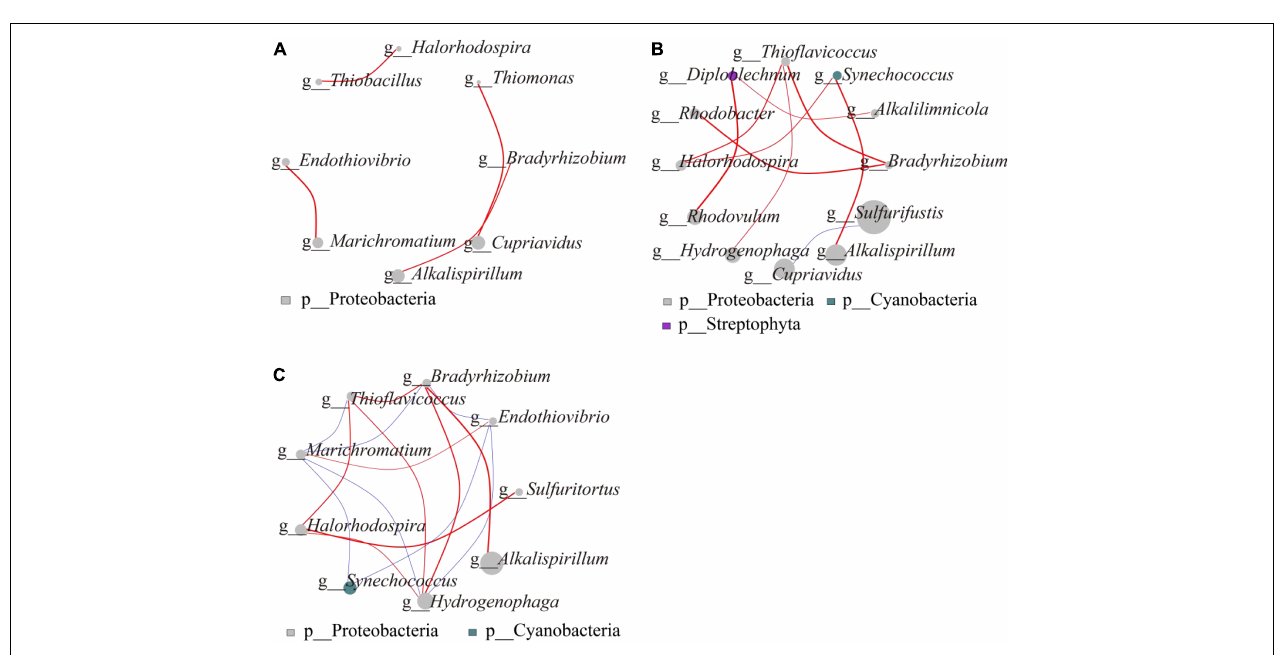
FIGURE 4 | Microbial network interaction of carbon-fixing microorganisms ( A , microbial network interaction on gentle slope; B , microbial network interaction on steep slopes; C , network interaction between gentle slope and steep slope). The size of the dot in the graph represents the abundance and the thickness of the line represents the correlation; the color of the dot represents the door to which it belongs, the red line represents a positive correlation, and the blue line represents a negative